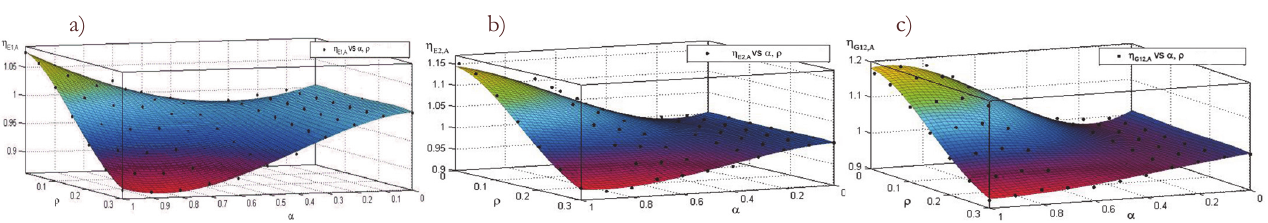
Figure 20: Correction factors vs. relative density and irregularity parameter: a)  E1,A ; b)  E2,A ; c)  G12,A .